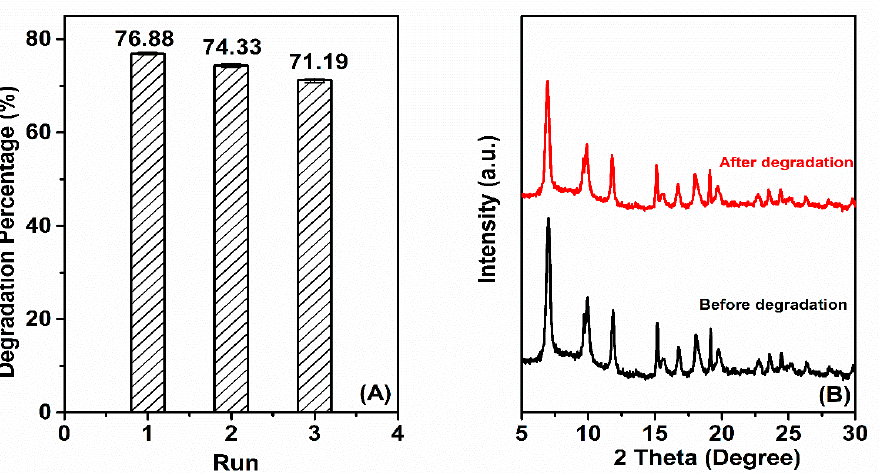
Figure 10. The reability test of the degradation of RhB over 15% Fe/Ti-MOFs ( A ), and the XRD pattern of 15% Fe/Ti-MOFs before and after degradation performance ( B